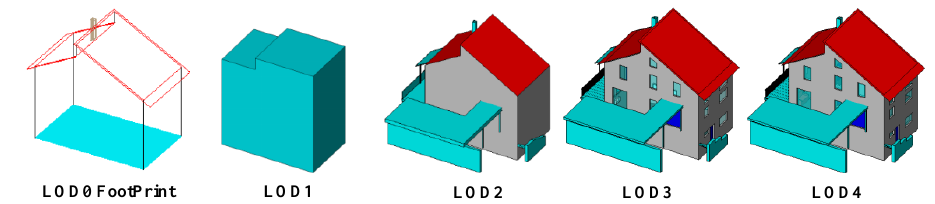
Figure 1. Different levels of detail of building models according to OGC City Geography Markup Language (CityGML) 2.0